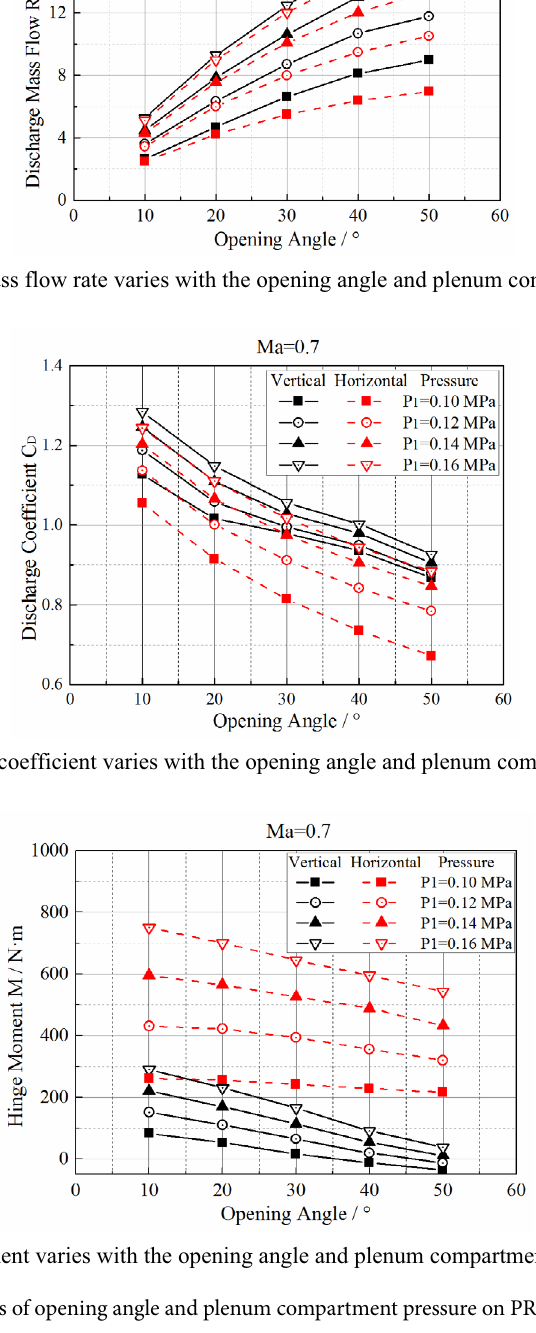
Figure 11. Effects of opening angle and plenum compartment pressure on PRD discharge